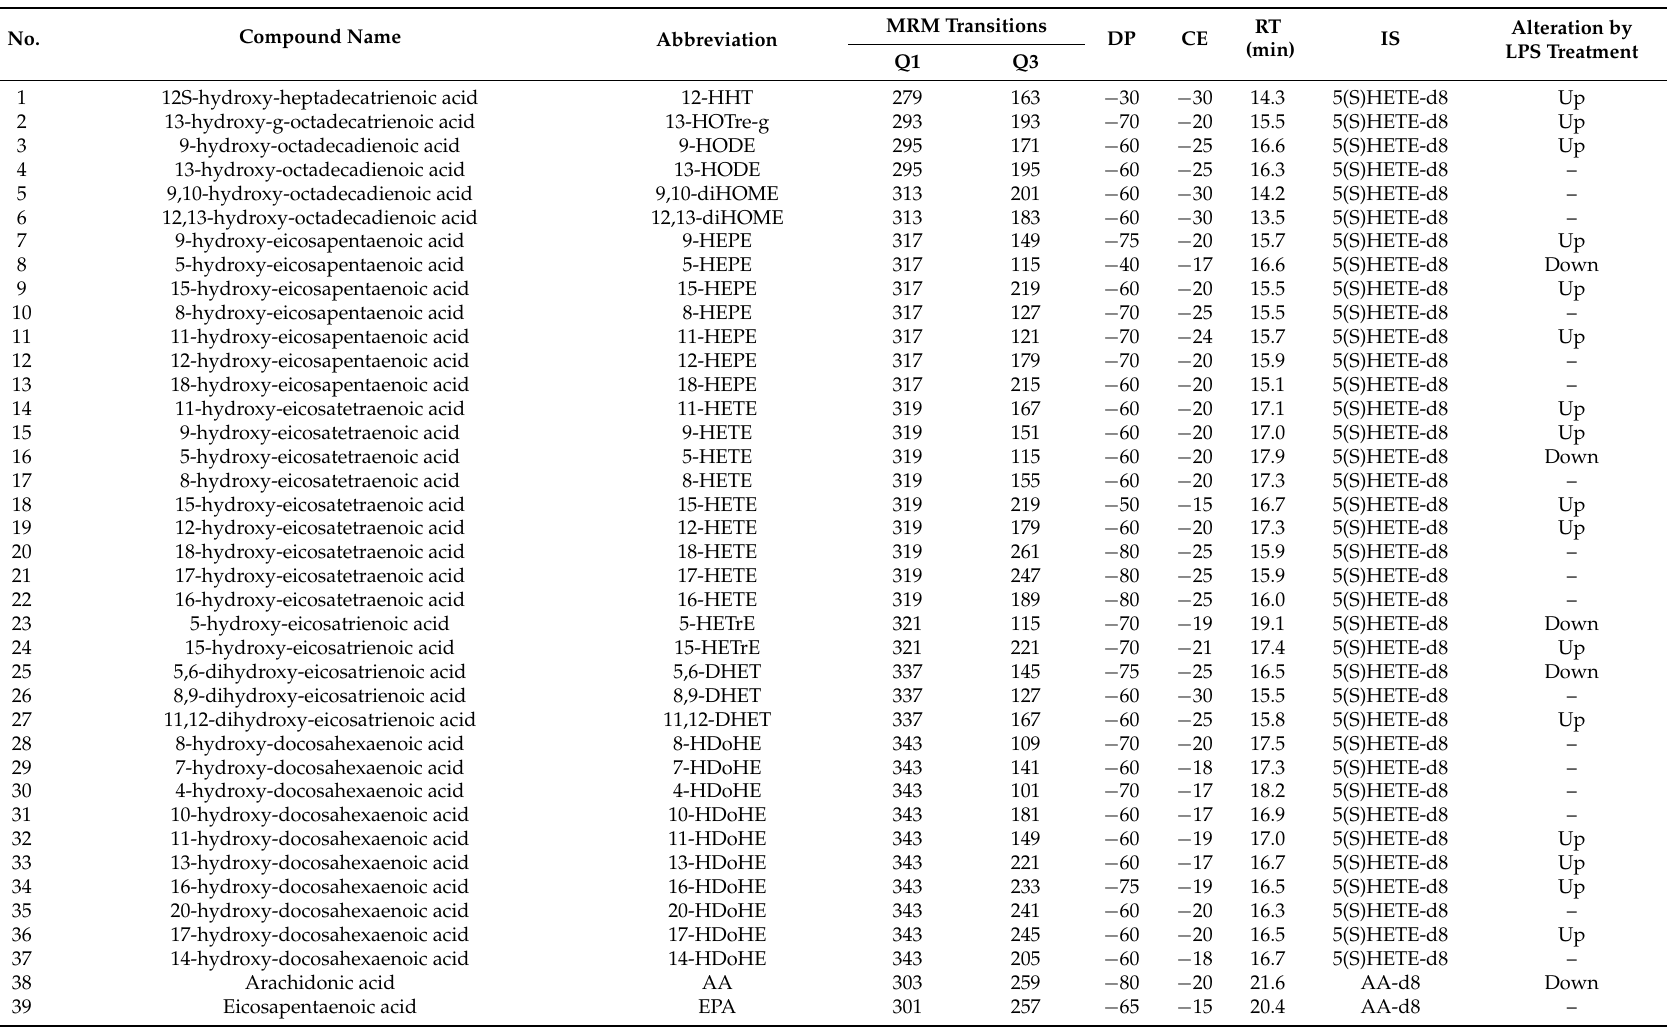
Table 3. Eicosanoids identified in RAW264.7